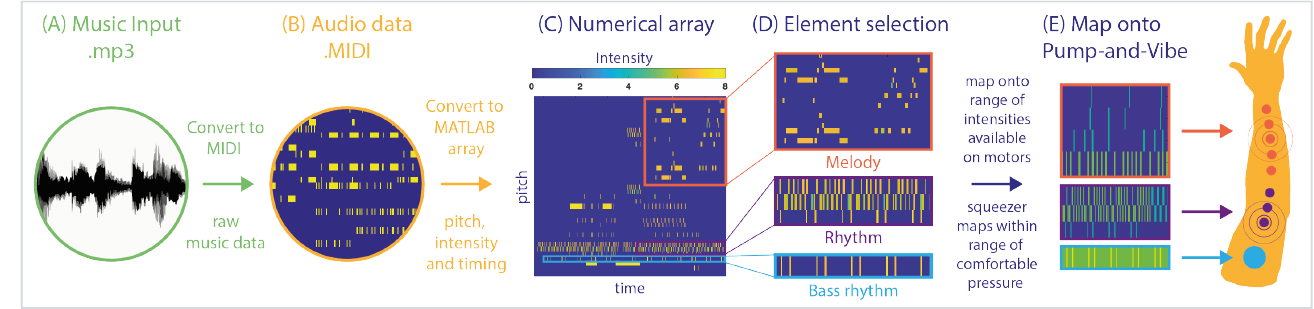
Figure 3. Schematic of the FeelMusic mapping process for projecting music onto Pump-and-Vibe. Composing Novel Tactile Pieces for